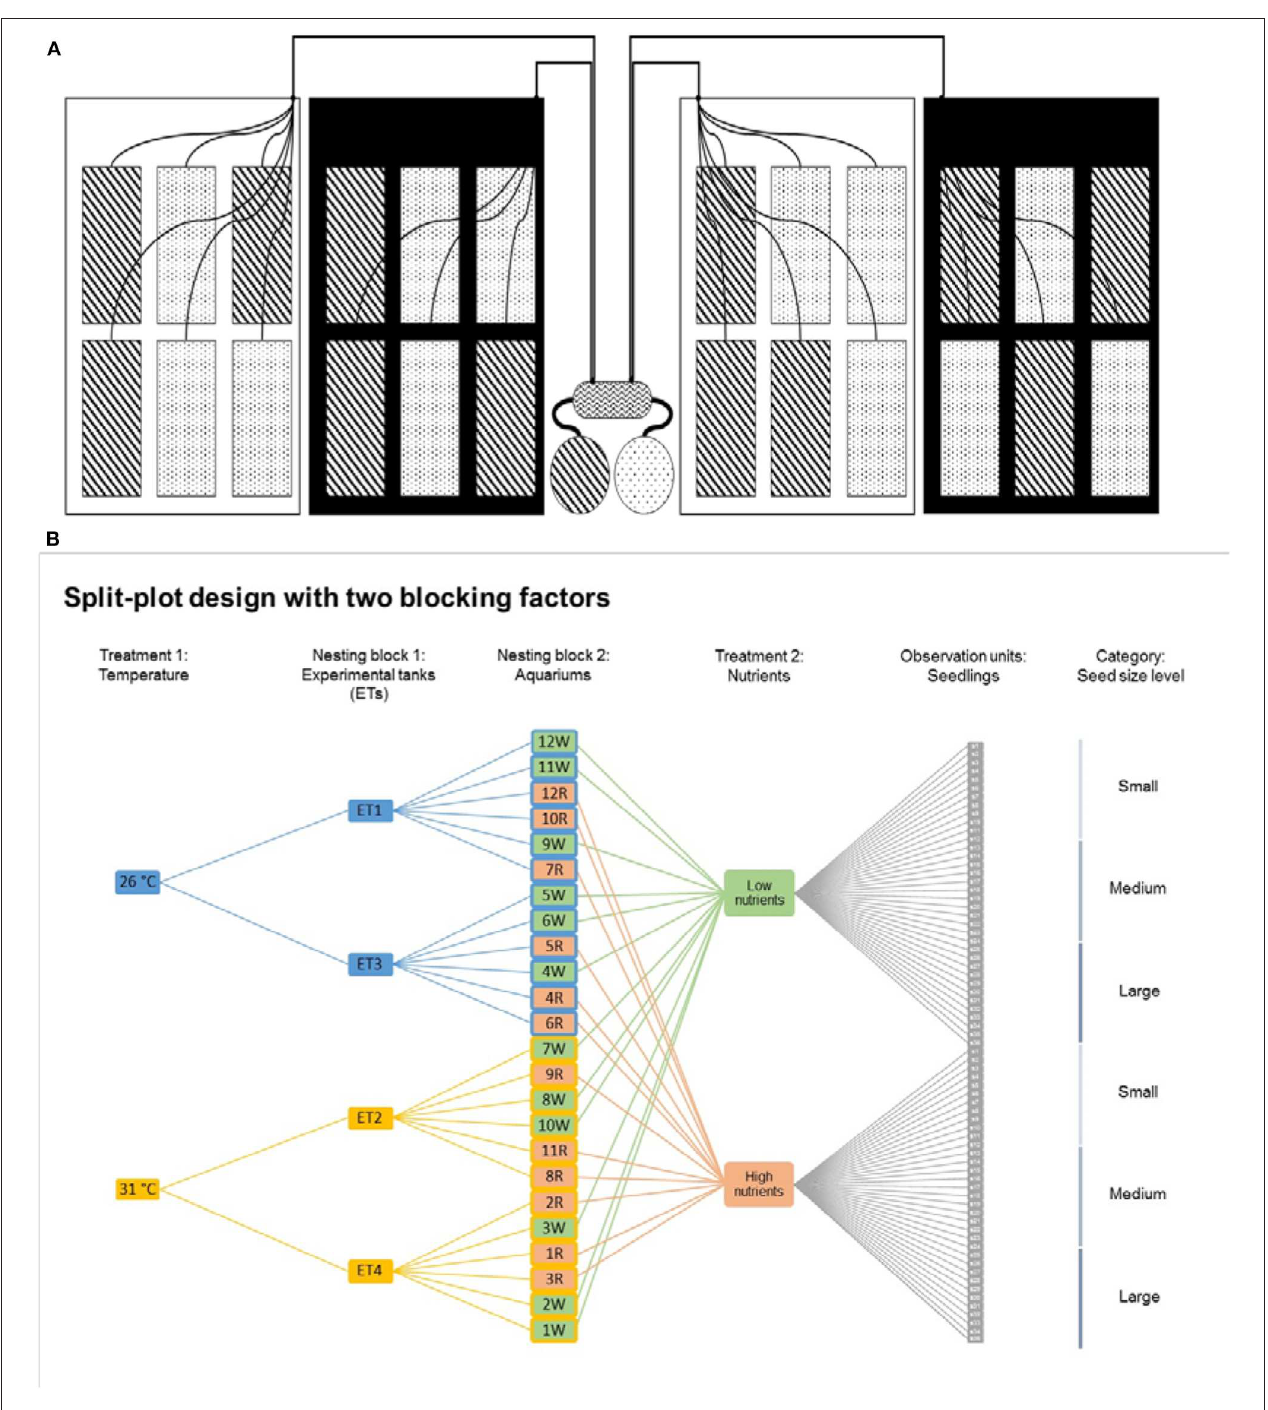
FIGURE 1 | (A) Nutrient and temperature split-plot experimental design. Artificial seawater was individually supplied to aquaria ( n = 24) from reservoirs with either high nutrient (dot boxes/circle) or low nutrient artificial seawater (strip boxes/circle) using a peristaltic pump. Six aquaria were placed in each experimental tank (ET) that acted as a water bath maintaining a constant temperature of either 26 ◦ C (white boxes) or 31 ◦ C (black boxes), with no interaction between aquaria that acted as replicates ( n = 6). (B) Experimental split-plot design with two blocking factors. Temperature and nutrient treatments are the fixed effects (explanatory variables) in the model, and they are fully crossed (nutrient treatments are not nested by temperature treatments). Temperature, as it groups ETs and aquaria, is a group level predictor. Nutrients, as it groups the observation units (seedlings) is a data level predictor. ET and aquaria are nesting variables, this means that ET nests the aquaria and the aquaria nests the observation units (seedlings). The seedlings are also further classified as large, medium and small.